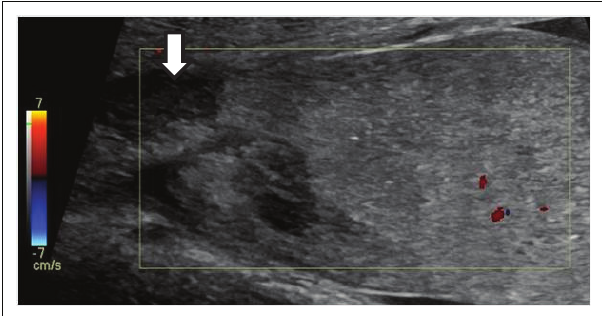
FIGURE 9: A 30-year-old male patient with a left-sided undescended testis: (a) Ultrasound imaging in the left inguinal location showed an atrophic and echogenic testis (bold white arrowhead). Postoperative findings were consistent with testicular non-seminomatous germ cell tumour and epididymis disjunction. (b) Contrast computed tomography for systemic work-up revealed necrotic heterogeneous lymph nodal metastasis (bold white arrow) in the left para-aortic location, which regressed after